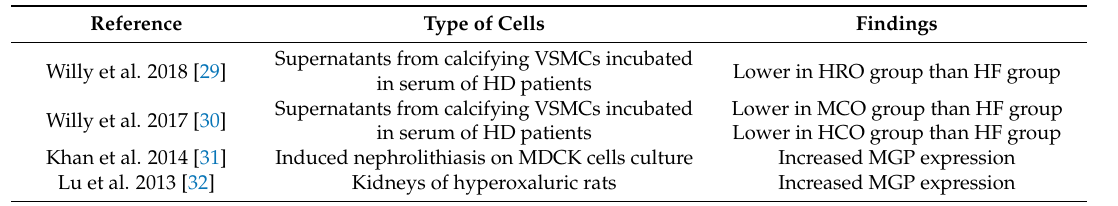
Table 3. In vitro studies concerning